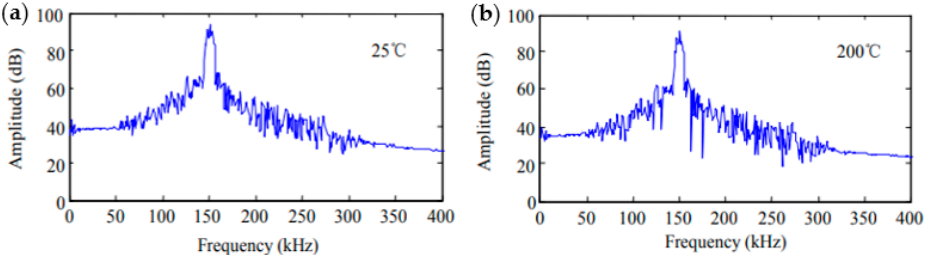
Figure 10. The frequency response of the novel high temperature fibre Bragg grating across the evaluated temperature range at: ( a ) 25 °C and; ( b ) 200 °C [45].